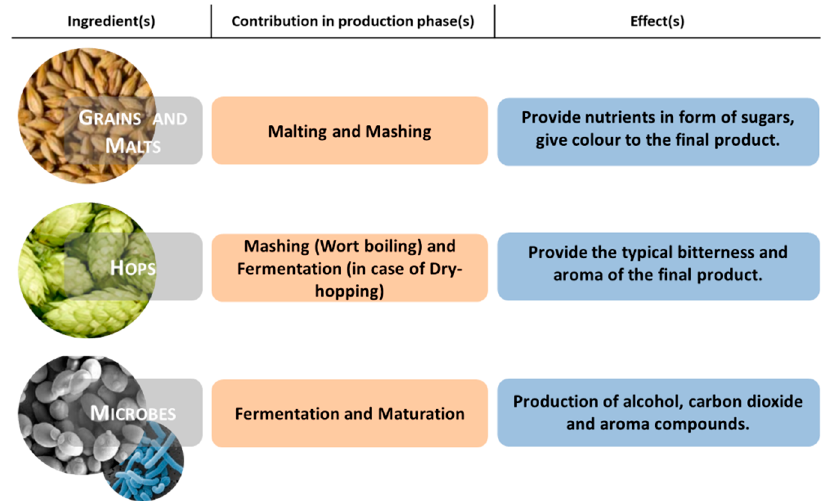
Figure 1. Contribution of the main ingredients in the beer production process and their effects on the final product.